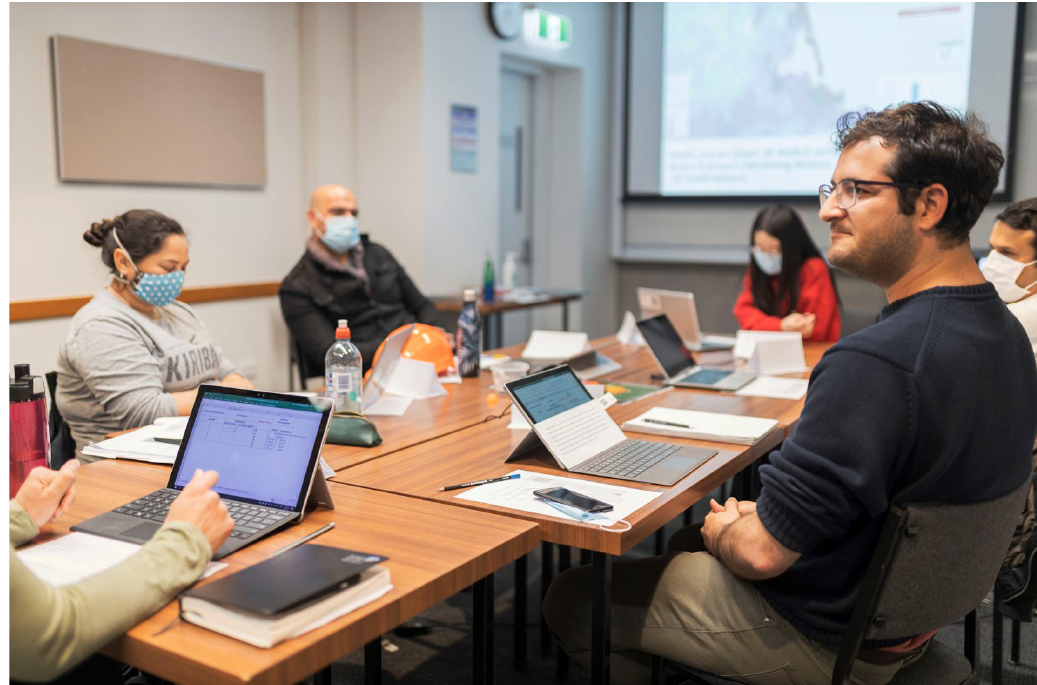
Figure 4. Playing With Uncertainty: Trial exercise with graduate students at the University of Canterbury, New